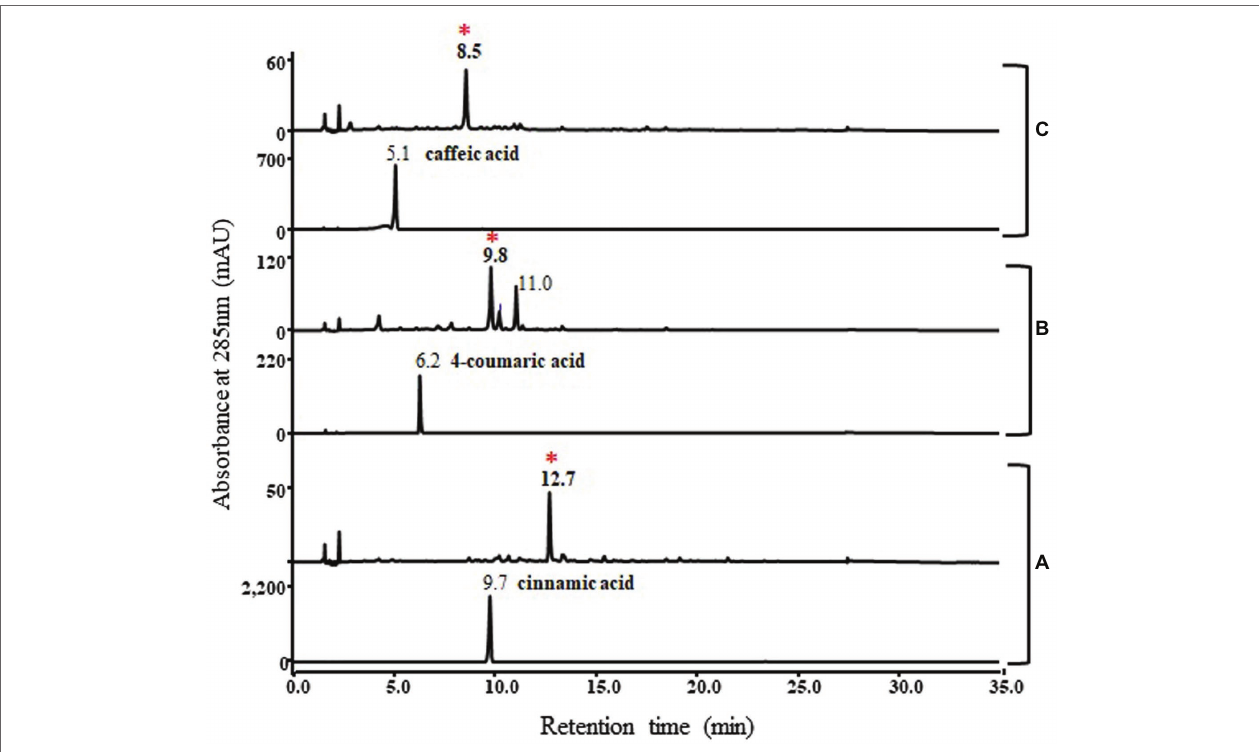
FIGURE 5 | HPLC profile of bioconversion experiments with cinnamic acid (A), 4-coumaric acid (B), and caffeic acid (C). Lower panels represent standard phenylpropanoic acids and upper panels represent reaction results. The absorbance was monitored at 280 nm. Cinnamic acid, 4-coumaric acid, and caffeic acid formed new peaks (12.7 min, 9.8 min, and 8.5 min, respectively) corresponding to the molecular weights of different chalcone compounds, which are denoted by asterisks. The mass spectra of the asterisked peaks are shown in Supplementary Figure S1